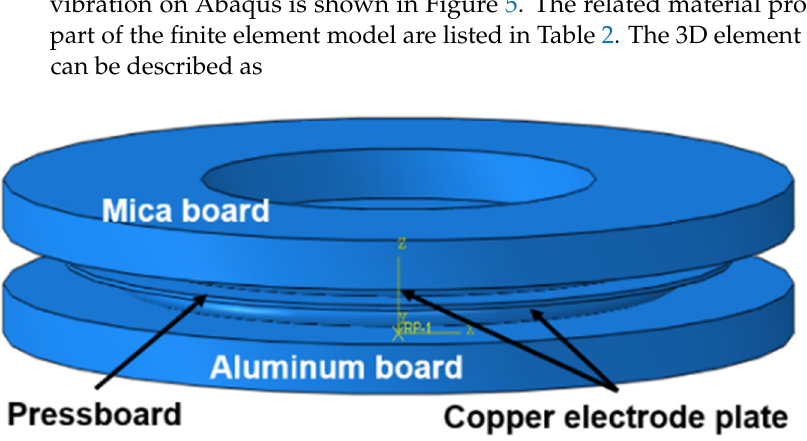
Figure 5. The 3D finite model of the pressboard vibration. Table 2. Material properties for the finite element model of the pressboard